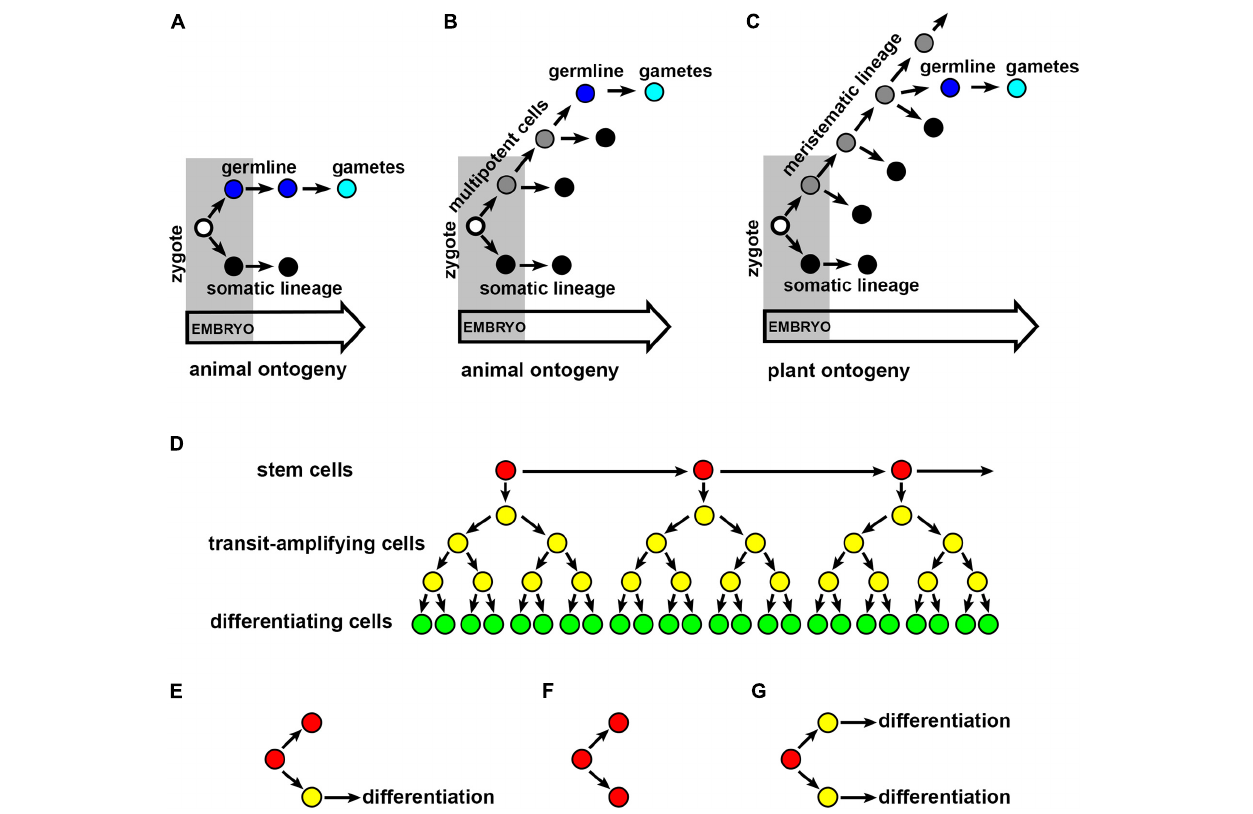
FIGURE 1 | Cell lineages minimizing the risk of heritable mutations. Establishment of the germline and somatic lineages in animals (A,B) and plants (C) . (A) In most of vertebrates (e.g., mouse and chicken) and ecdysozoans (e.g., Drosophila and Caenorhabditis elegans ) the germline (blue) producing gametes (cyan) is specified and separated from somatic lineages (black) during embryogenesis. (B) In other animals (e.g., flatworms, cnidarians, or sponges), the germline is specified during post-embryonic development from multipotent lineages (gray) that produce also somatic lineages. (C) In plants, the germline is specified during post-embryonic development from meristematic cell lineages (gray), that produces also somatic lineages. Empty circle, zygote; black circle, somatic lineage; blue circle, germline; cyan circle, gametes; gray circle, multipotent or meristematic lineage. (D) Hierarchical organization of stem cell lineage. Slowly dividing stem cells (red) produce descendant stem cells and faster dividing transit-amplifying cells (yellow) that eventually enter a differentiation pathway (green). (E–G) The fate of stem cell descendants. (E) Stem cell descendants after the asymmetric division acquire a different fate: the stem cell (red) and the cell that ultimately differentiate (yellow). Stem cell descendants after the symmetric division acquire the same fate: either both become stem cells (F) , or both cells ultimately differentiate (G) .